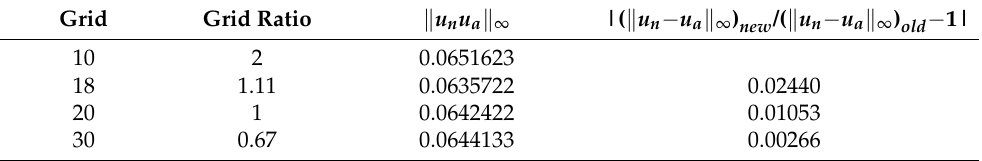
Table 2. Grid independence study of Poiseuille flow with four Lagrangian mesh schemes. Grid Grid